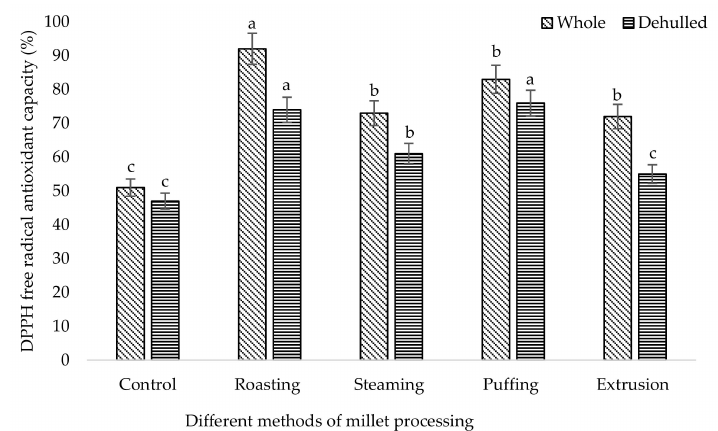
Figure 1. DPPH free radical antioxidant capacity of processed broomcorn millet. DPPH, 2, 2-diphenyl-1 picryl hydrazyl. The values are the mean ± SE. ( n = 3). Di ff erent lowercase letters within the bar indicate significant di ff erences ( p < 0.05) according to the analysis of variance